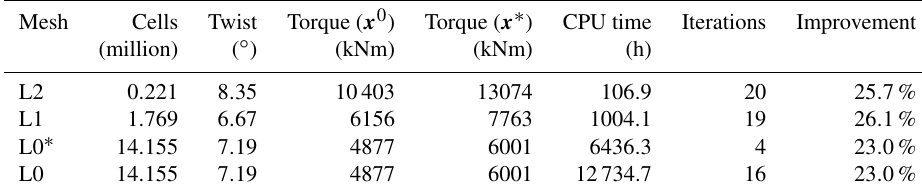
Table 6. Pitch design variable optimization. All runs used 216 processors. This means that, for example, the L2 optimization had an actual wall-clock time just under 30min.